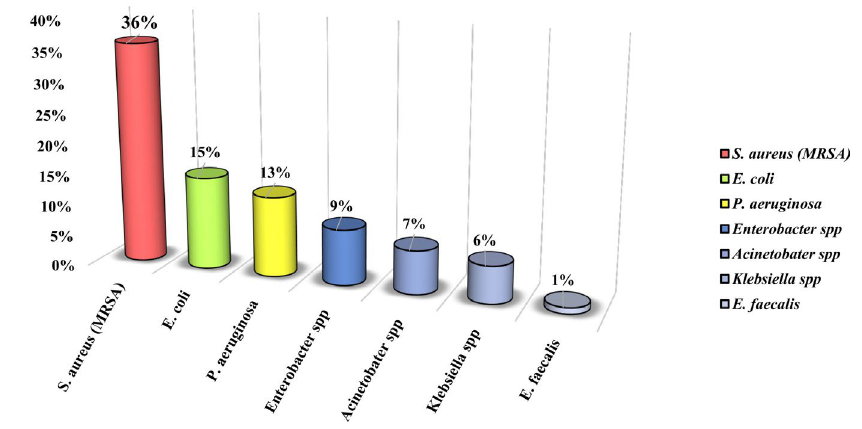
Fig. 1. The Most Common Causative Agent of Wound Infection. Adopted from (Gupta et al., 2015).